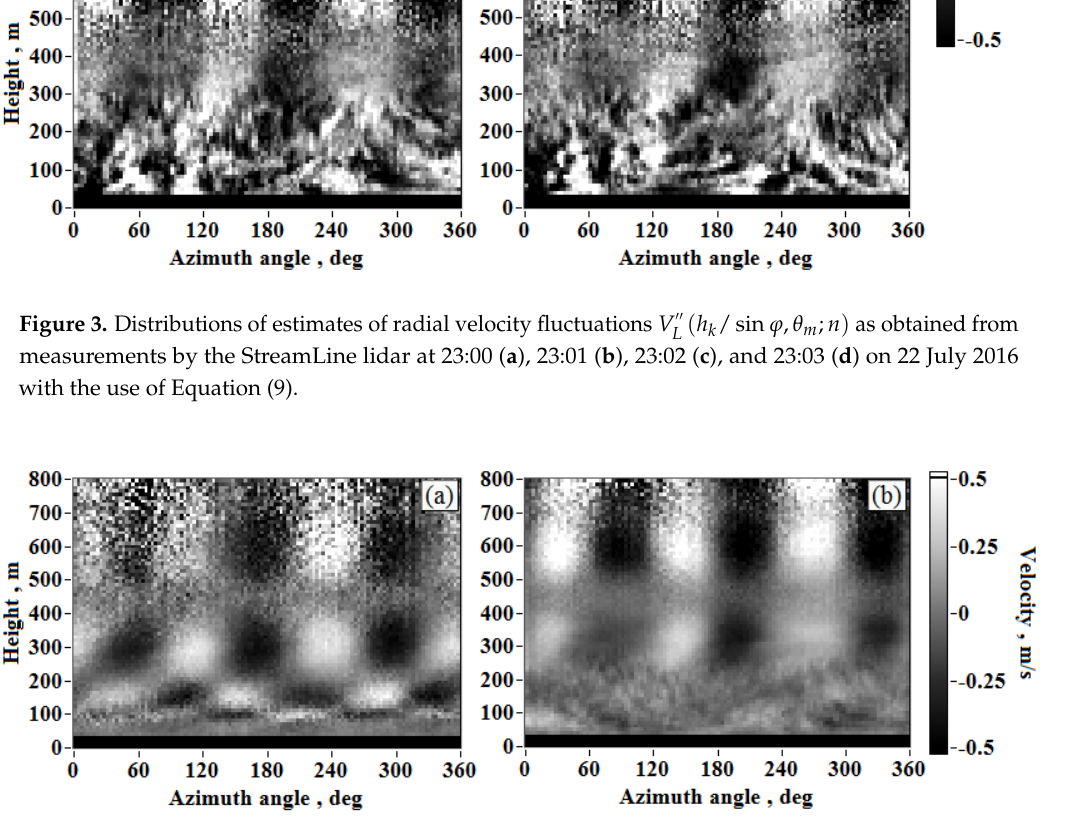
Figure 4. Distributions of averaged estimates of radial velocity fluctuations (cid:101) V L ( h k / sin ϕ , θ m ) as obtained from measurements by the StreamLine lidar from 22:00 to 22:30 on 21 July 2016 ( a ) and from 00:00 to 00:30 on 23 July 2016 ( b ) with the use of Equation (11) at N =